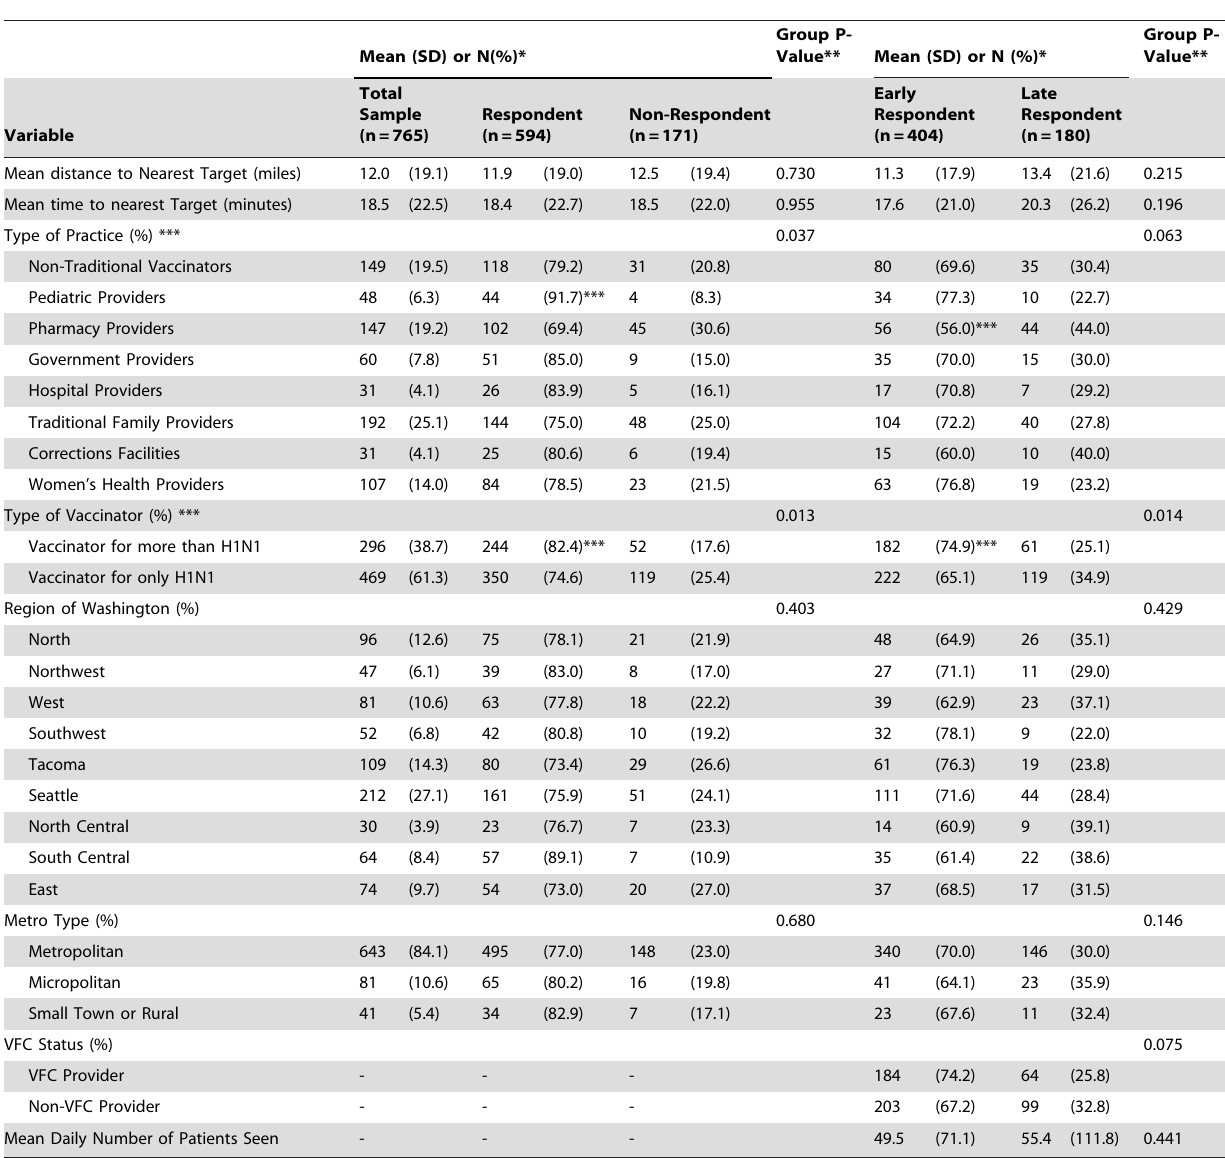
Table 1. Demographic characteristics by response status and response